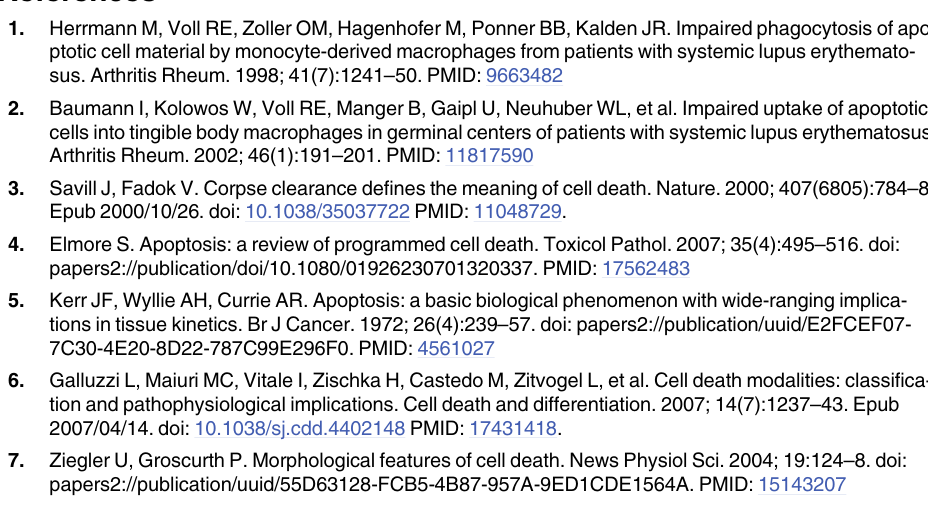
S3 Fig. Additional electron microscopy images of AnnV + IgM - and AnnV + IgM + cell popula- tions. Mouse thymocytes rendered apoptotic by overnight culture were exposed to Balb/c plasma. On the basis of FSC/SSC thymocytes were then sorted into AnnV - IgM - , AnnV + IgM - and AnnV + IgM + populations (as illustrated in Fig 1D) by FACS and examined by electron microscopy. Images were taken using a Philips CM120 transmission electron microscope with a Gatan Orius CCD camera. Whole image contrast/brightness was adjusted using ImageJ. Rep- resentative images of AnnV + IgM - and AnnV + IgM + cells are shown. (TIF) S4 Fig. Mouse circulating IgM binds AnnV + human Jurkat cells. Human Jurkat cells were treated with camptothecin for 16-hours to induce apoptosis. Jurkat cells were then exposed to PBS or human serum as a source of IgM prior to incubation with anti-human IgM antibody. Some Jurkat cells were exposed to PBS, Balb/c plasma as a source of mouse IgM or purified mouse pentameric isotype control antibodies (unconjugated mouse (Balb/c) IgM κ isotype con- trol). Samples were then incubated with an anti-mouse IgM antibody. IgM binding was assessed by flow cytometry. Annexin-V (AnnV) staining, assessed by flow cytometry, was used to determine the level of non-apoptotic (AnnV - ) and apoptotic (AnnV + ) cells. Apoptotic Jurkat cells were gated on the basis of AnnV positivity and the proportion of AnnV + IgM + Jurkat cells was assessed. A proportion of apoptotic Jurkat cells exposed to human serum or Balb/c plasma exhibited IgM binding. Representative histograms are depicted ( n = 4 per group).